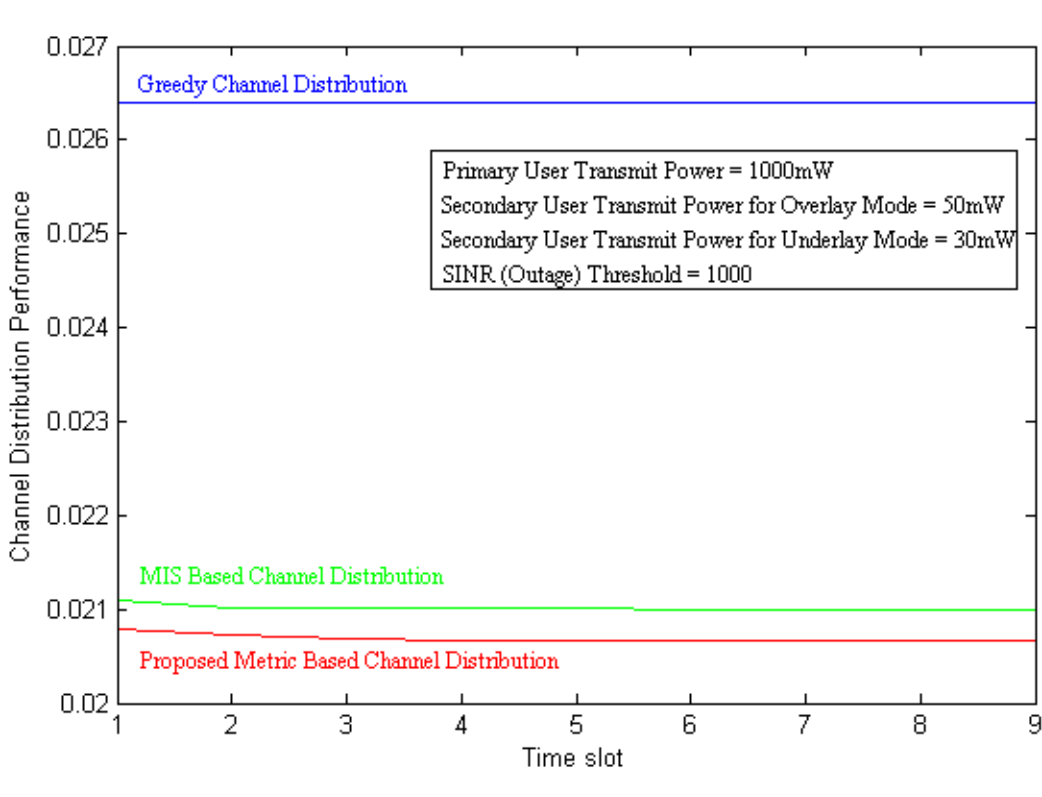
Figure 15. ChDistFairness aginst time slots for 3 algorithms when the SINR (outage) threshold is